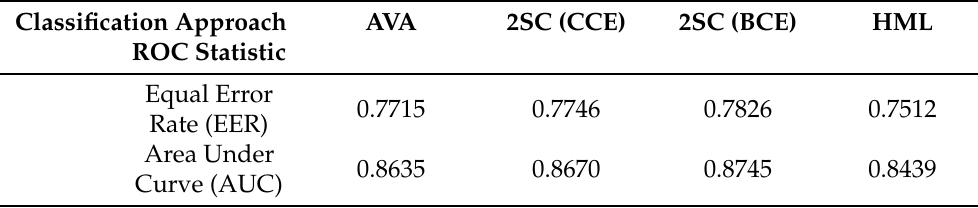
Table 4. ROC curves statistics of different classification approaches on our revisited CompCars dataset: All-vs.-all (AVA), Two-step cascade (2SC) with two losses, and Hierarchical multilabel (HML). Classification